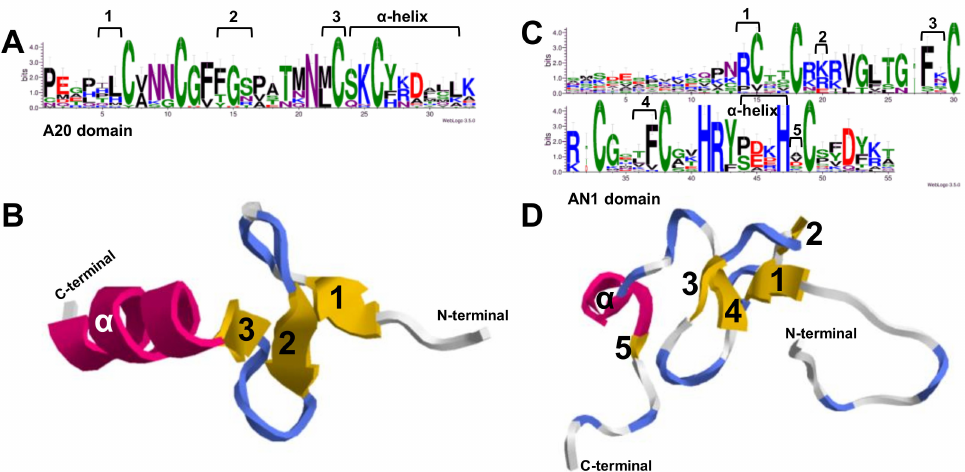
Figure 3. ( A ) Sequence logos for A20 domain in 26 MdSAP proteins, generated via WebLogo; ( B ) Three-dimensional tertiary structural model of A20 domain (PDB ID: 2KZY.1.A); ( C ) Sequence logos of AN1 domain in 28 MdSAP proteins; and ( D ) Three-dimensional tertiary structural model of AN1 domain (PDB ID: 1WFP.1.A). Within each stack, symbol height indicates the relative frequency of each amino acid at that position. Logos for the A20 domain and AN1 domain were obtained through multiple alignments of 26 and 28 MdSAP protein sequences, respectively. At the top of the corresponding amino acid sequences, arabic numbers (1–5) indicate β -sheets in A20 and AN1 domains. In ( B , D ), α -helices are red, β -sheets (arabic numbers 1–5) are yellow, and strands are blue/gray. Three-dimensional representations were generated with RasTop